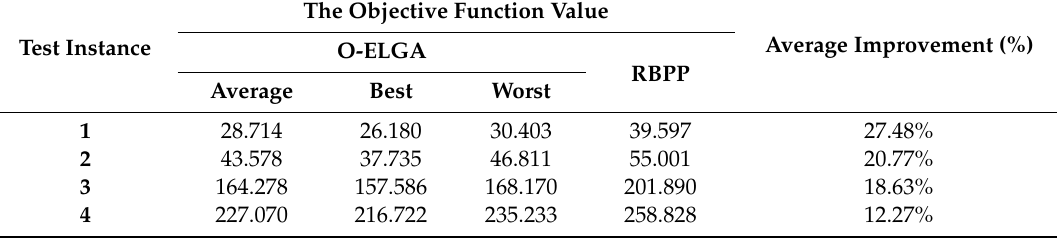
Table 4. Comparison of odd-even layered genetic algorithm (O-ELGA) and the RBPP algorithm in the di ff erent test instances.